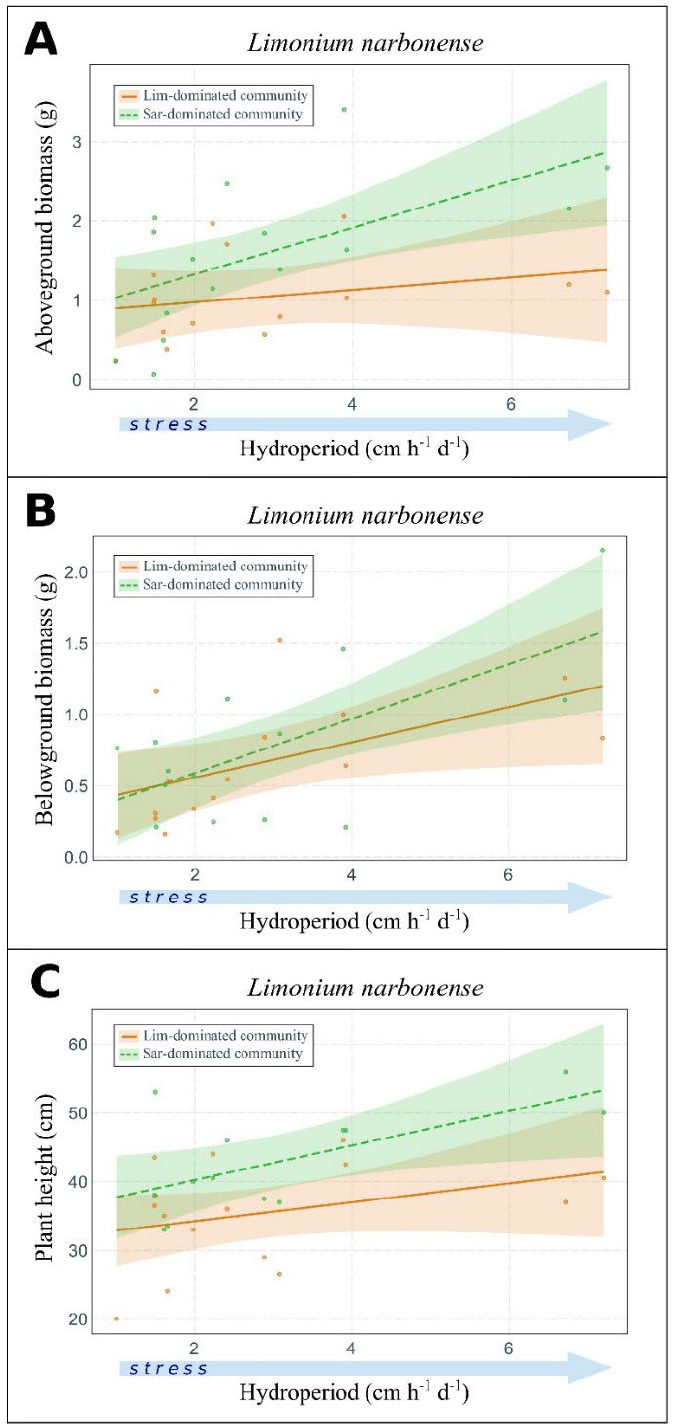
Figure 2. Effect of flooding intensity on Limonium narbonense growth traits. Changes of above- (( A ) R 2 = 0.35) and belowground biomass (( B ), R 2 = 0.37) and plant height (( C ) R 2 = 0.38) along the flooding gradient in monospecific stands or Sarcocornia fruticose -dominated plant communities. Light blue arrows indicate the increasing stress gradient of flooding. Only significant relationships obtained from ANOVA applied on linear models are shown (see Table S1). The interaction of flooding intensity and plant community type was not found to be statistically significant.